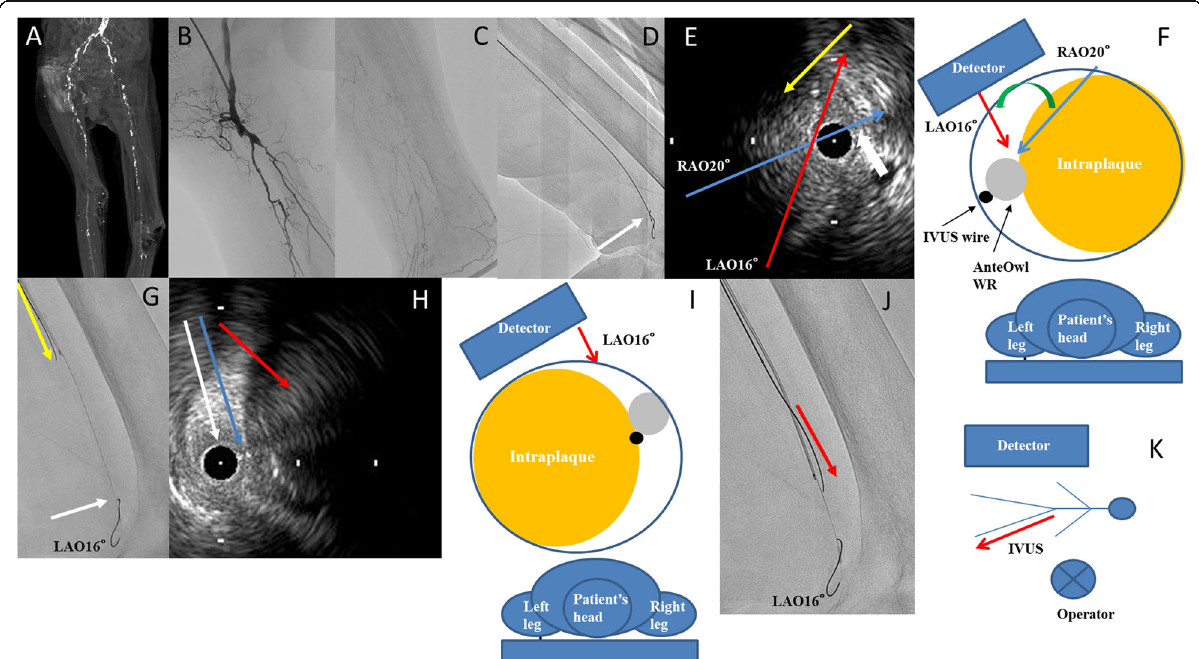
Fig. 3 a Preprocedural enhanced computed tomography. b, c Control angiography showed total occlusion from the proximal aspect of the superficial femoral artery to the popliteal artery. The distal true lumen of the popliteal artery was minute (white arrow). d AnteOwl WR intravascular ultrasound (AnteOwl IVUS) could be advanced to the popliteal artery (white arrow). e IVUS findings of a superficial femoral artery distal lesion. The IVUS catheter was in the subintimal space. The white arrow shows the IVUS wire. The IVUS wire and transducer coincided with right anterior oblique 20° (blue arrow), and left anterior oblique 16° was maximally separated of IVUS and target plaque (red arrow). The yellow arrow shows that the direction of the second guidewire should be advanced. f Cross-sectional image from the proximal position (operator position). The transducer was on the surface side and the target plaque was on the right side of the IVUS catheter. g We converted the intravascular ultrasound (IVUS) findings into an angiographic image. The IVUS wire was on the right side (left anterior oblique side), the transducer was in the center, and the second guidewire was on the left side (right anterior oblique side) on angiography; these findings are almost the same as the IVUS findings in e White arrow shows the tip of AnteOwl WR IVUS. h, i IVUS findings of the popliteal artery lesion. The blue arrow shows the IVUS wire. The yellow arrow shows the IVUS transducer. The red arrow shows the direction of the target plaque at which we aimed. The target plaque was on the left side of the IVUS catheter. j The IVUS wire was in the center, the transducer was on the left side, the second guidewire was on the right side (left anterior oblique side) on angiography; these findings are almost the same as the IVUS findings.